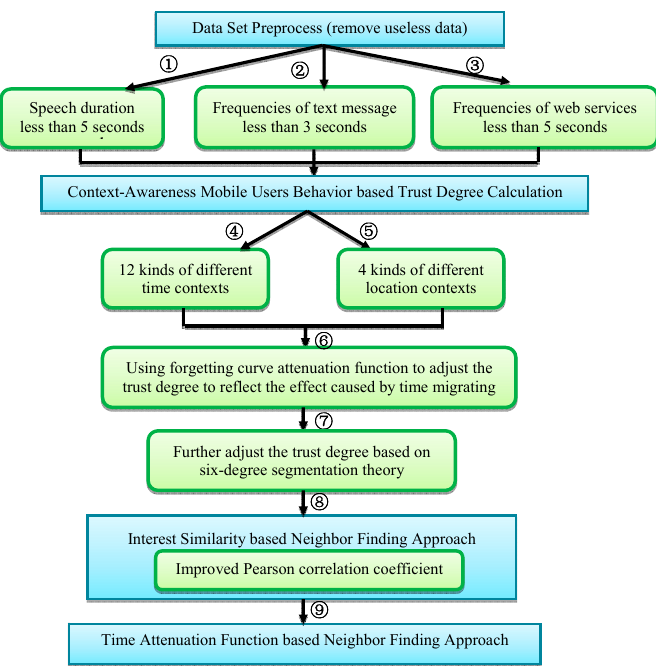
Figure 3. Overview of the proposed algorithm.